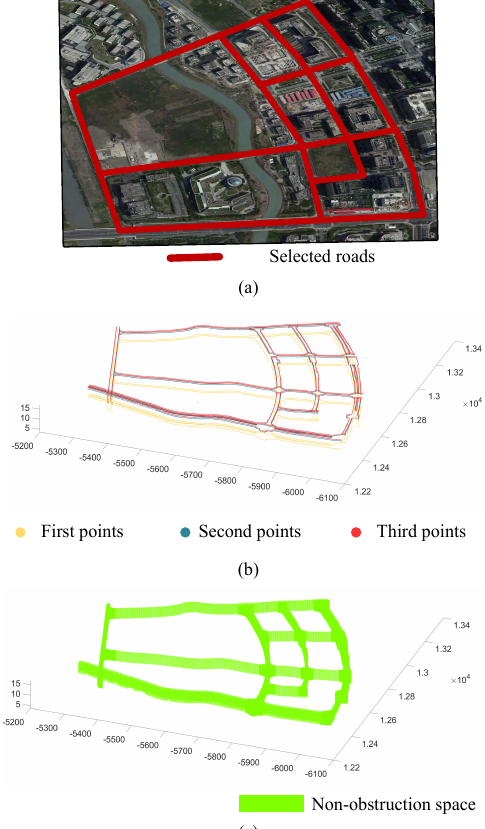
Figure 8. Non-obstruction space of the case area: (a) Selected roads, (b) Three class points, (c) Non-obstruction